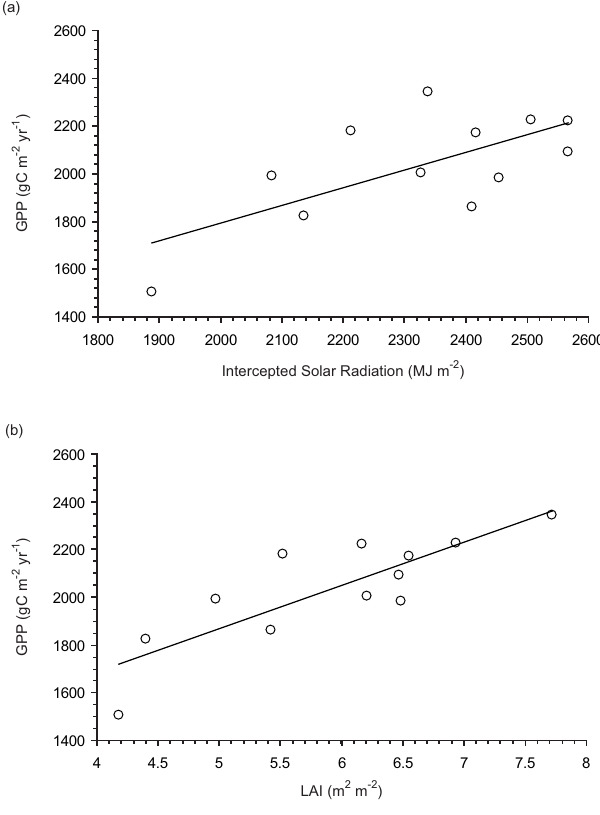
Fig. 8. Relationship between (a) annual GPP and intercepted solar radiation ( r 2 = 0 . 46, p < 0 . 05) and (b) annual GPP and peak LAI ( r 2 = 0 . 7, p < 0 . 001).